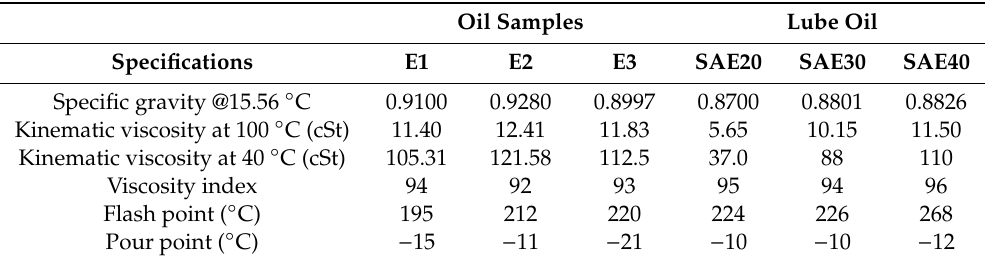
Table 2. Physical properties of the used oil samples.